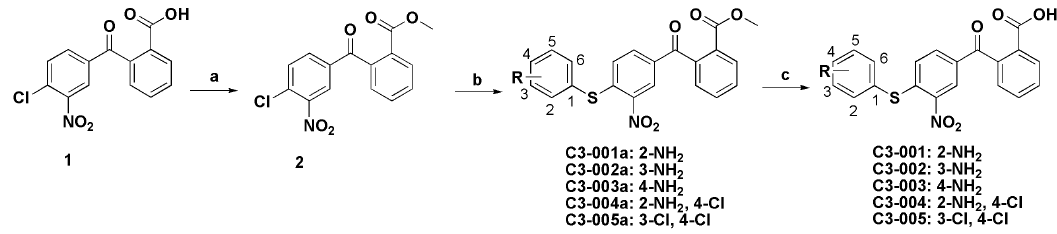
Table 2. Antimicrobial and inhibitory activities of C3